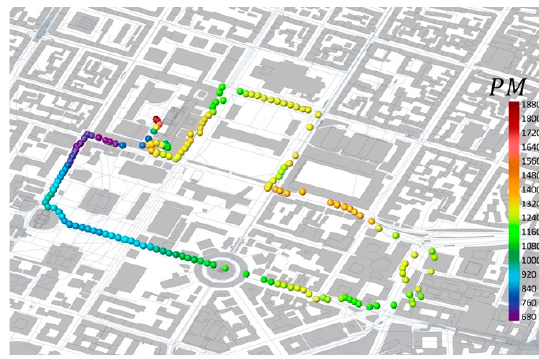
Figure 30. Particulate matter maps: ( a ) PM 2.5; ( b ) PM 10. ISPRS Int. J. Geo-Inf. 2019 , 8 , 76